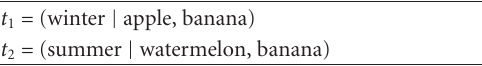
Table 2: Legal examples.